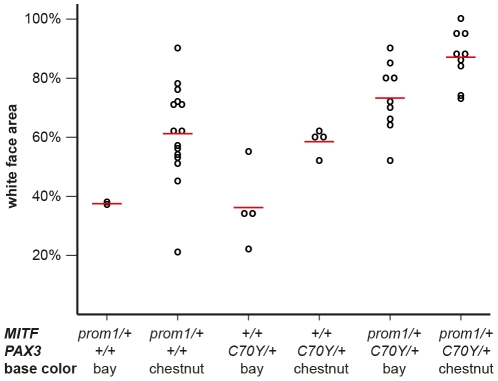
White face area in splashed white Quarter Horses with specific genotypes.Raw phenotypes for individual horses are indicated as black circles. The average values for each genotype class are indicated by red lines. While there is considerable variation in the phenotypic expression, the average proportion of white face area is higher in chestnut horses versus bay horses and it is also higher in horses carrying both the MITFprom1 and the PAX3C70Y allele than in horses carrying only one of the two splashed white alleles (p<0.05, two-sided Welch t-test). The white face areas of all horses and the p-values between all different genotype classes are given in Table S2.